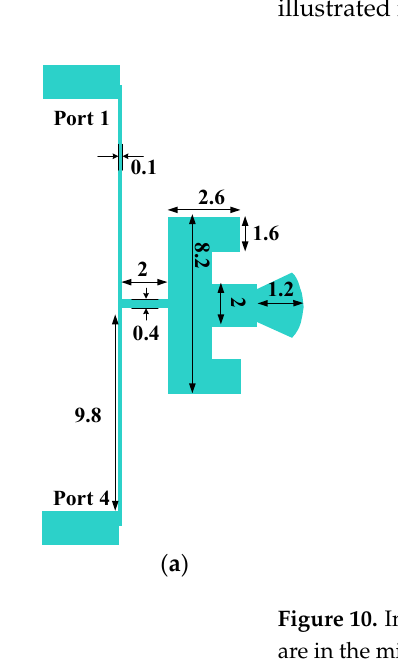
Figure 9. Initial vertical resonator: ( a ) layout and ( b ) frequency response. All dimensions are in the millimeter unit.